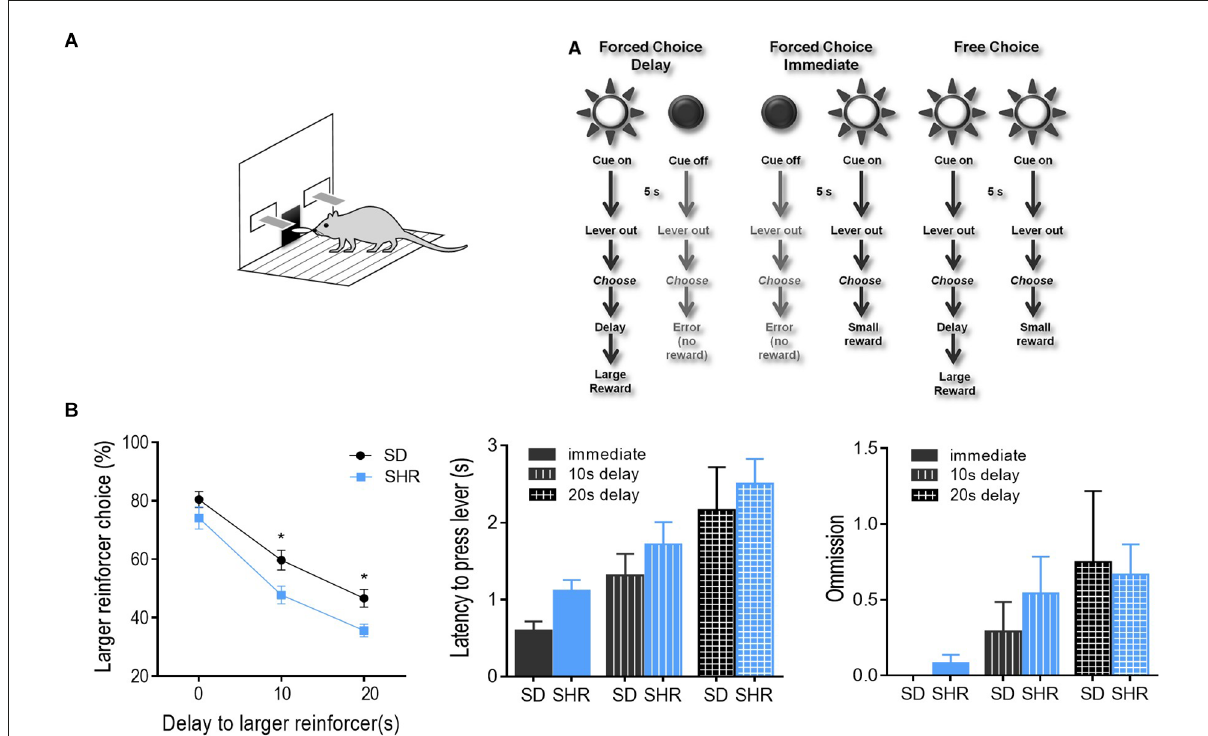
FIGURE1 Percentage of large reinforcer choice in SD and SHR rats in delay discounting task. (A) Experimental design. Rats underwent 40 trials of forced choices (block 1 and 2) before being tested for 20 trials of free choices (block 3) for delay discounting. (B) Free choice behavior in SD and SHR rats during the delay discounting task with a delay time of 0, 10, and 20 s. The percentage of larger reinforcer choices decreased as the delay to reward increased in both SD and SHR rats while the SHR rats showed less preference to the larger reinforcer compared with SD rats (* p < 0.05). Data are presented as mean ± sem. SD, Sprague Dawley; SHR, spontaneously hypertensive